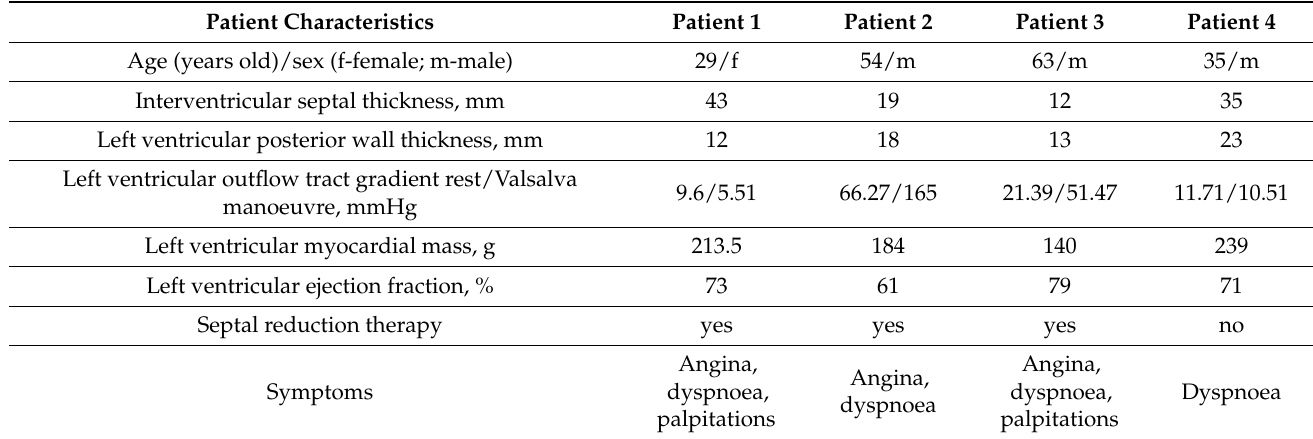
Table 4. Clinical data on the HCM